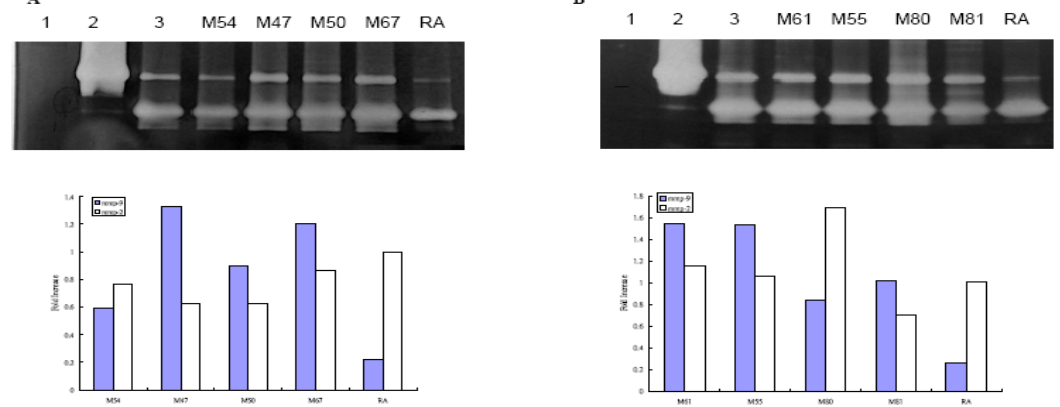
Figure 1. Effect of Taiwanese native plants on MMP-2 and –9 activities by zymography gel.